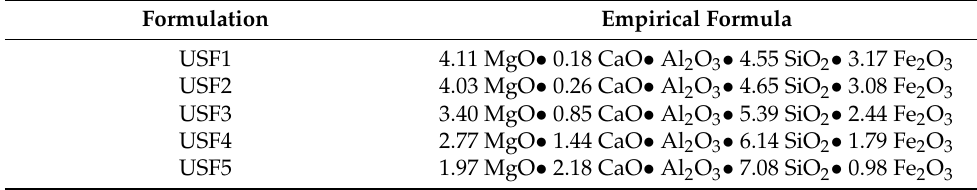
Table 4. Formulation of NMW